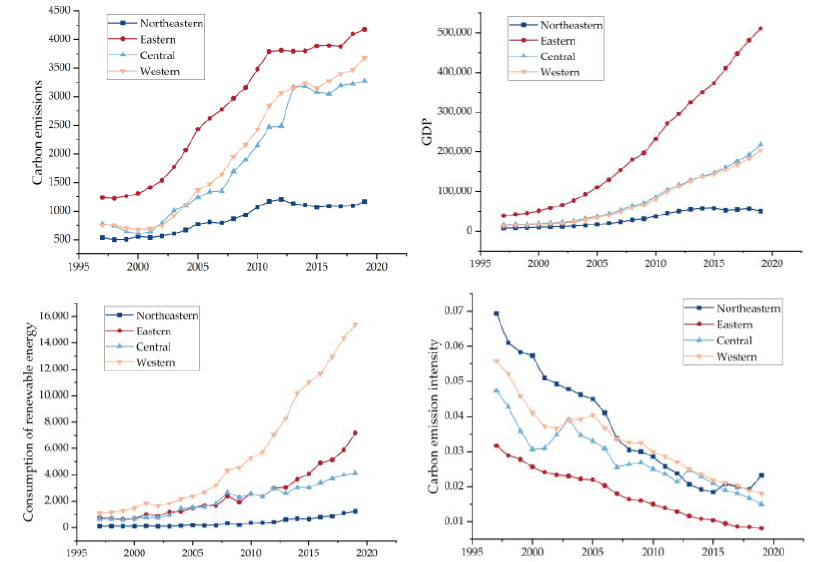
Figure 2. Descriptive statistical trend of variables by region.